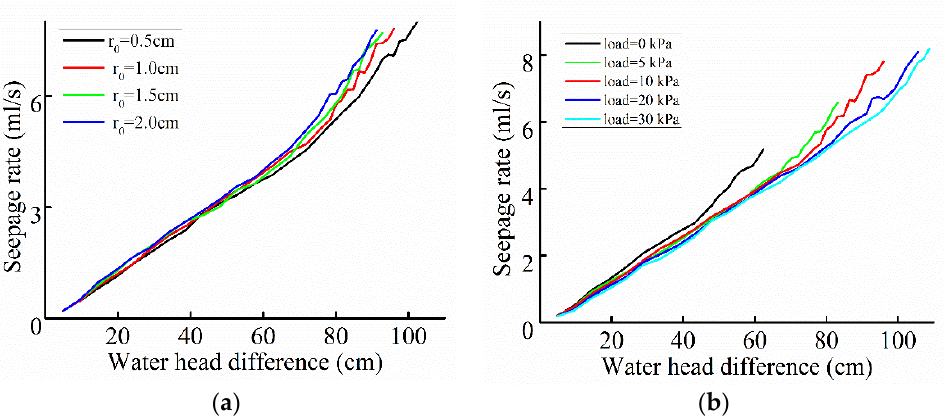
Figure 7. Seepage rate versus water head difference. ( a ) seepage rate under different hole radii and ( b ) seepage rate under different loads.